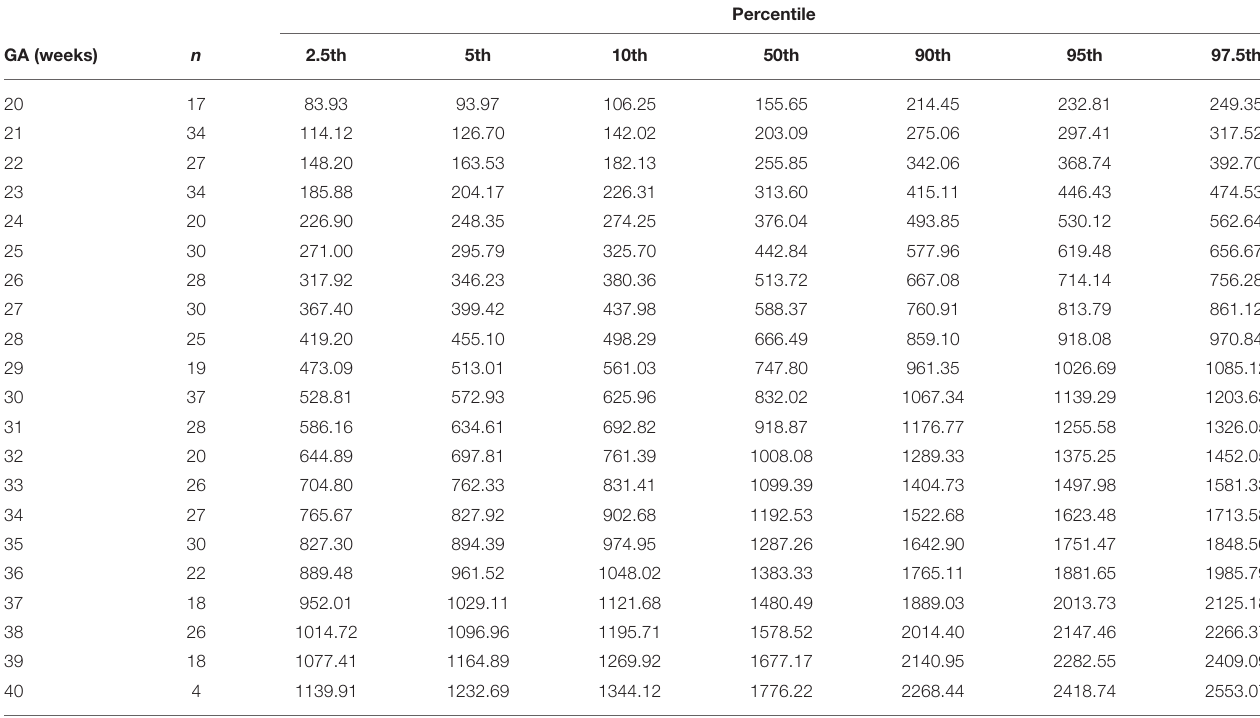
TABLE 9 | Percentiles of combined ventricular cardiac output (ml/min) at 20-40 weeks of gestational age (GA).